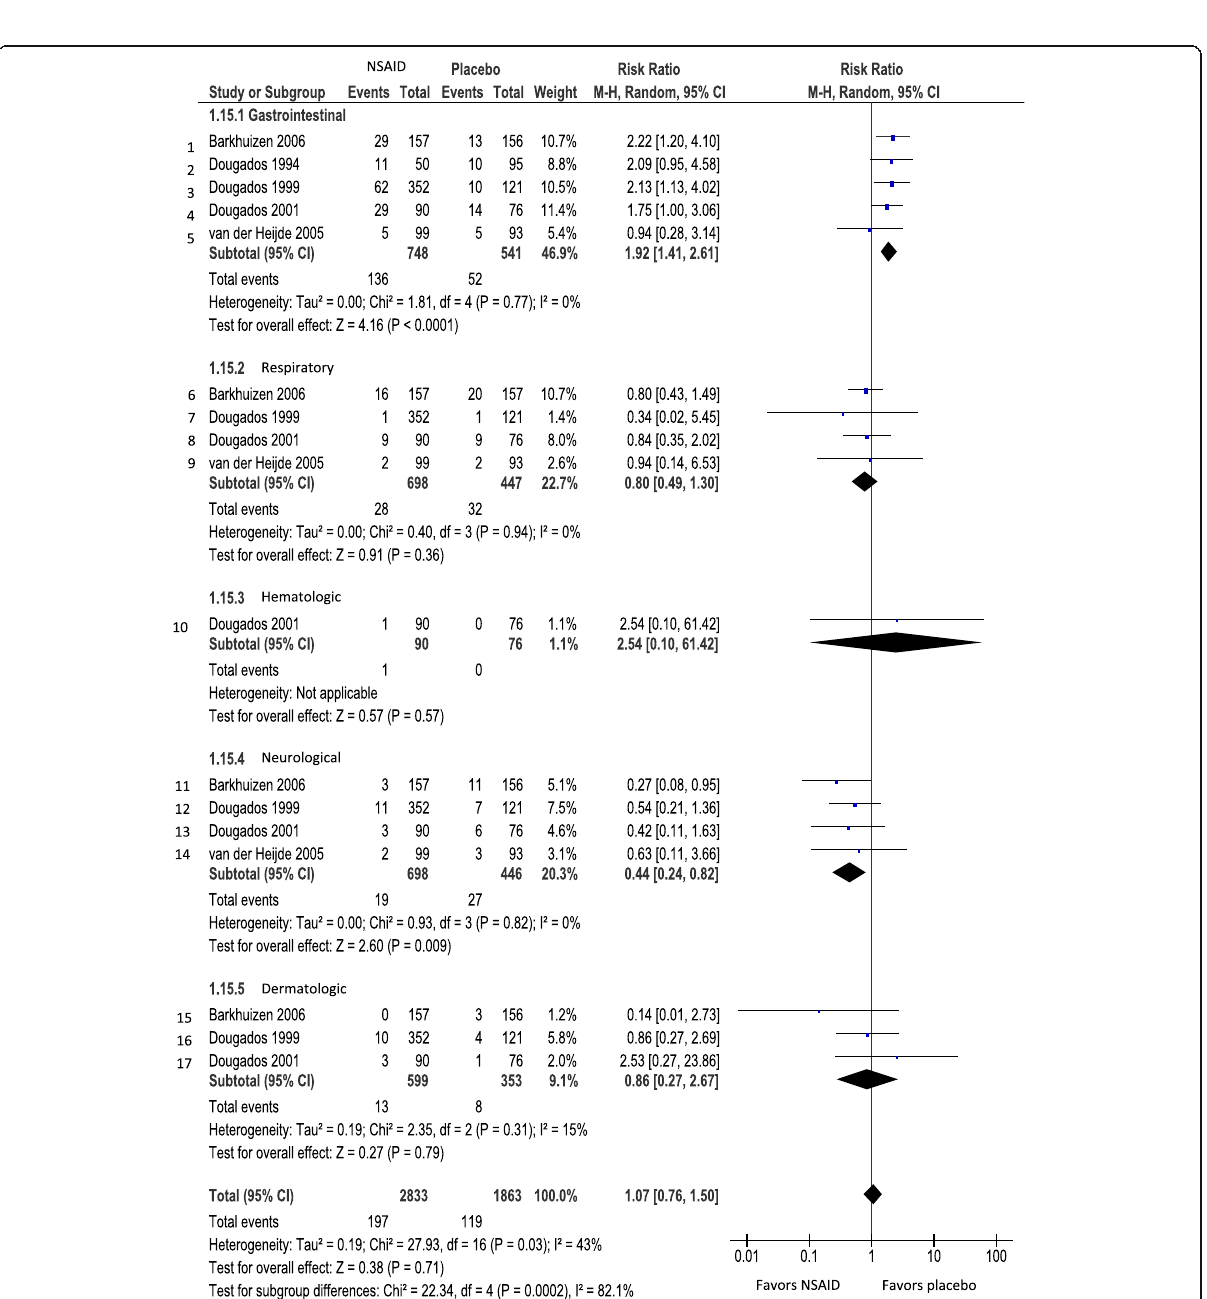
Fig. 7 Incidence of adverse events per organic system in the comparison of traditional NSAIDs versus placebo in patients with ankylosing spondylitis: meta-analyses of five randomized clinical trials. Subtitle: (1) Naproxen 500 mg vs placebo. (2) Ximoprofen 30 mg vs placebo. (3) NSAIDs (meloxicam 15 mg, meloxicam 22.5 mg, or piroxicam) vs placebo. (4) Ketoprofen 200 mg vs placebo. (5) Naproxen 1000 mg vs placebo. (6) Naproxen 500 mg vs placebo. (7) NSAIDs (meloxicam 15 mg, meloxicam 22.5 mg, or piroxicam) vs placebo. (8) Ketoprofen 200 mg vs placebo. (9) Naproxen 1000 mg vs placebo. (10) Ketoprofen 200 mg vs placebo. (11) Naproxen 500 mg vs placebo. (12) NSAIDs (meloxicam 15 mg, meloxicam 22.5 mg or piroxicam) vs placebo. (13) Ketoprofen 200 mg vs placebo. (14) Naproxen 1000 mg vs placebo. (15) Naproxen 500 mg vs placebo. (16) NSAIDs (meloxicam 15 mg, meloxicam 22.5 mg or piroxicam) vs placebo. (17) Ketoprofen 200 mg vs